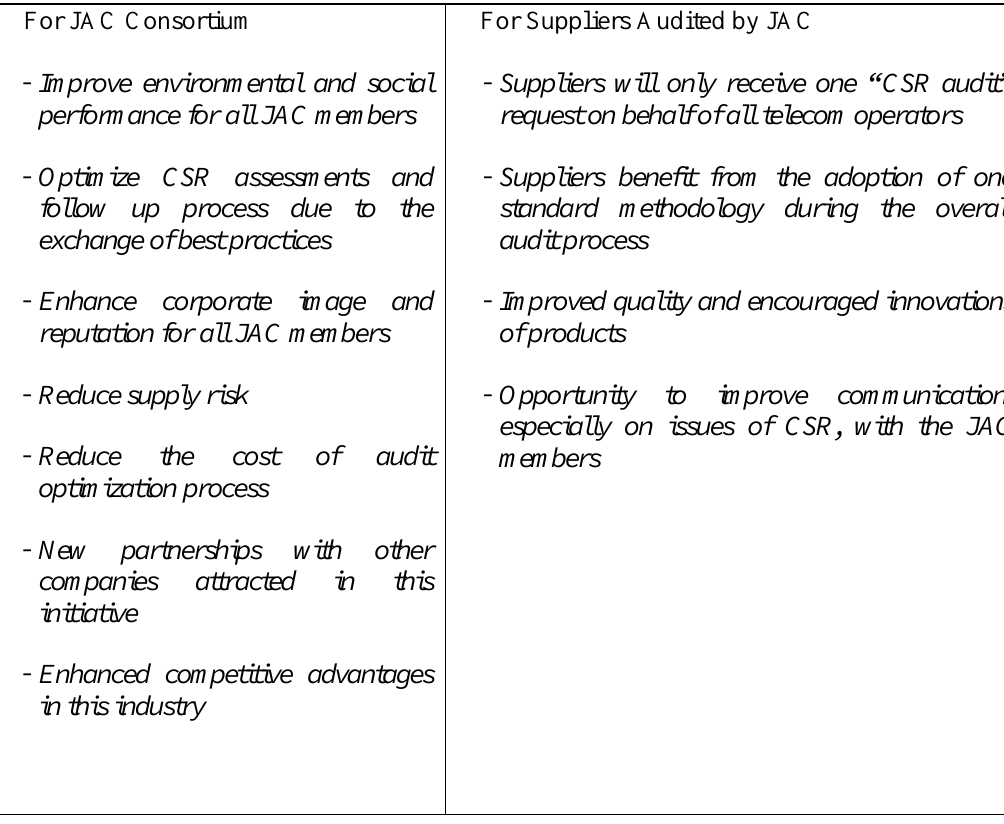
Table 2: Main Cooperation Benefits for JAC Members and their Suppliers For JAC